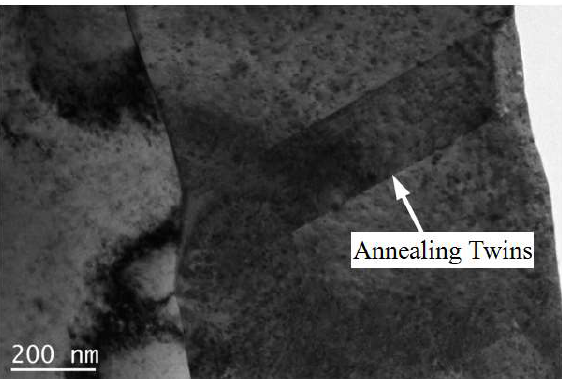
Figure 5. Annealing twins formed during annealing process observed by TEM.